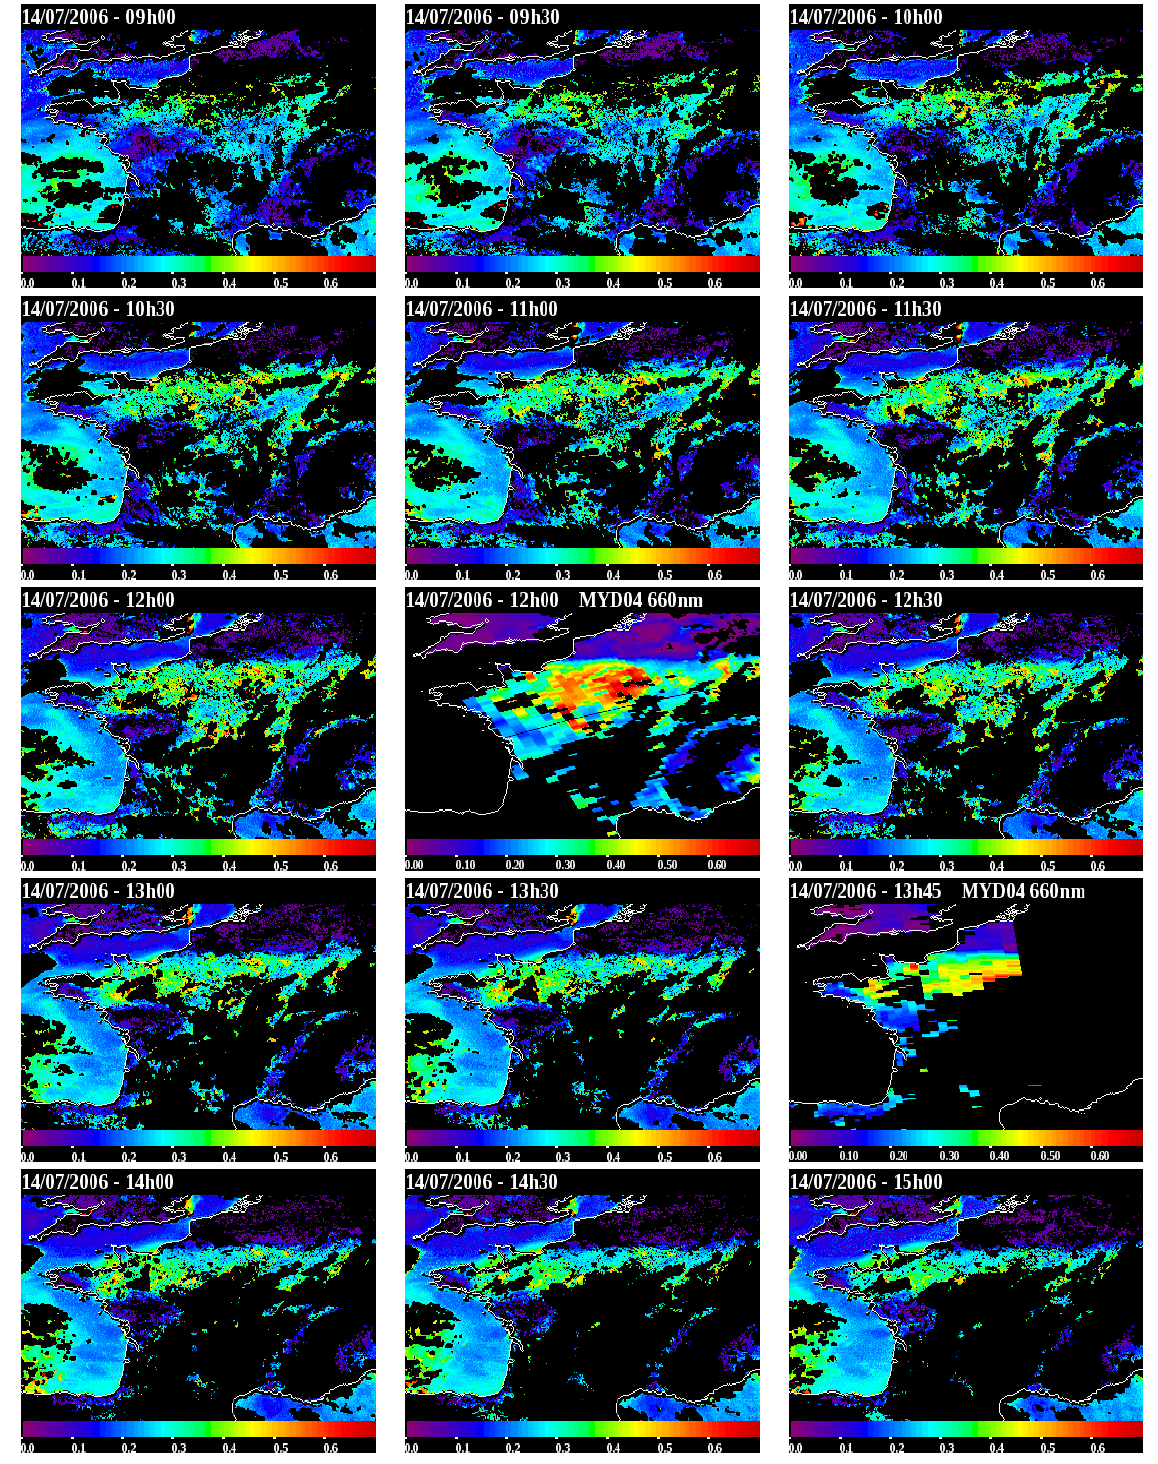
Fig. 8. Maps of aerosol optical thickness retrieved by SEVIRI at 0.6 µ m for the 14 July 2006 above France, Benelux and West Germany from 9:00 to 15:00. Two MODIS AQUA aerosol optical thickness level 2 maps are also showed at 12:00 and 13:45. The color scale is from 0 to 0.7.